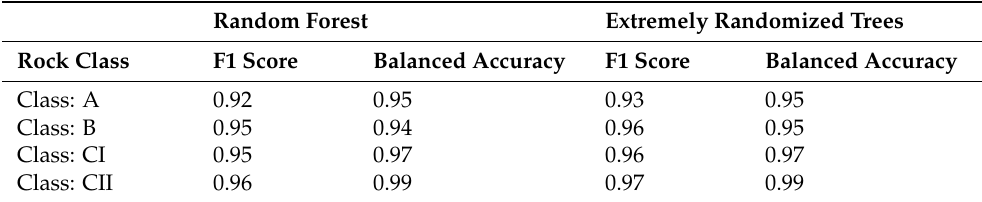
Table 6. Performance metrics of the ML models in predicting each rock